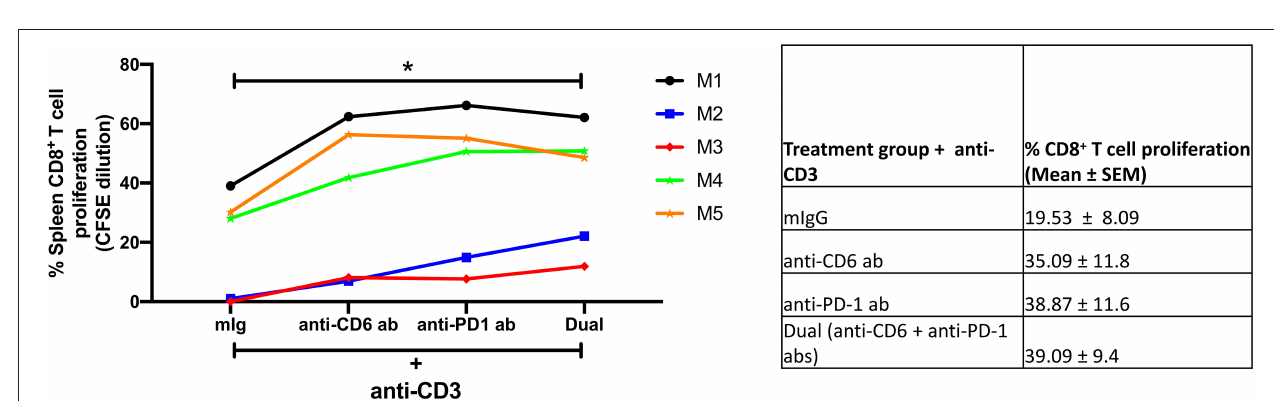
secretion, proliferation and cytotoxic capabilities compared to CD8 + CD6 − PD-1 + T-cells suggested a negative effect of